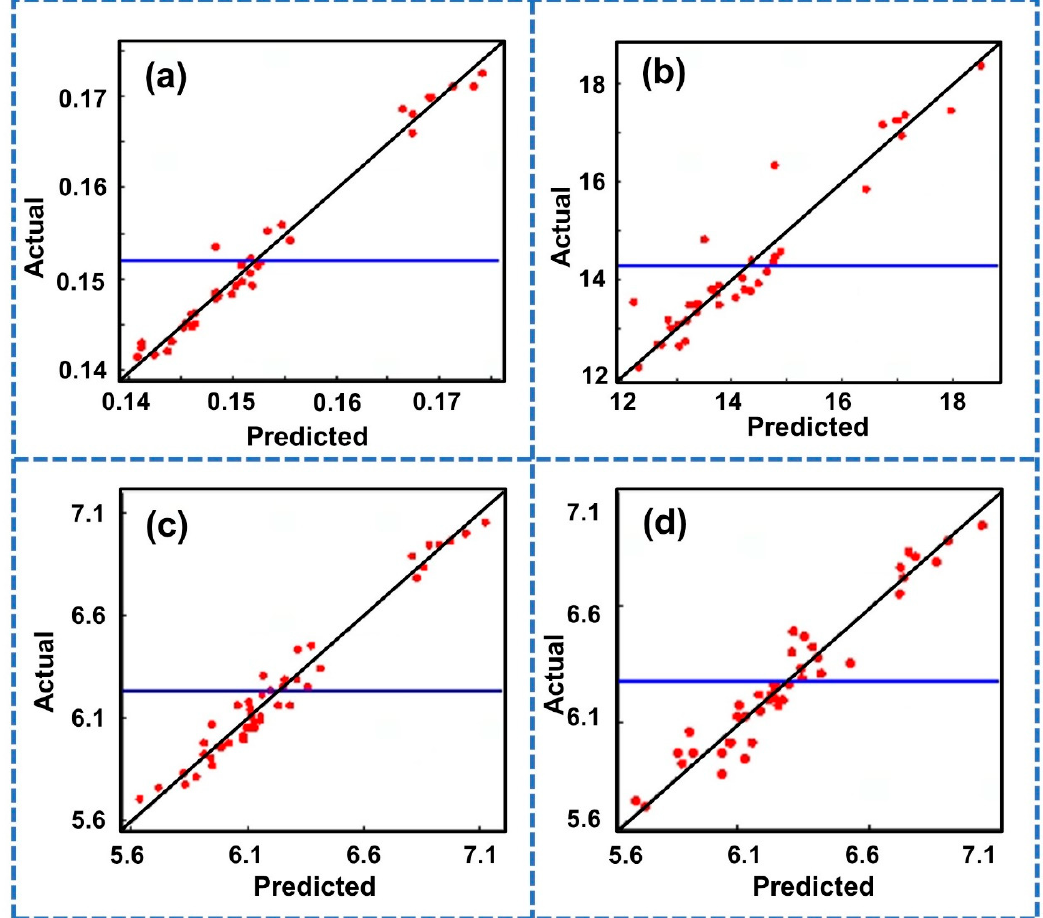
Figure 9. Residual analysis diagram of each response target of the RSM-Quadratic. ( a ) Maximum shrinkage ( Y 1 ). ( b ) Volume shrinkage ( Y 2 ). ( c ) Addendum diameter shrinkage ( Y 3 ). ( d ) Root circle diameter shrinkage ( Y 4